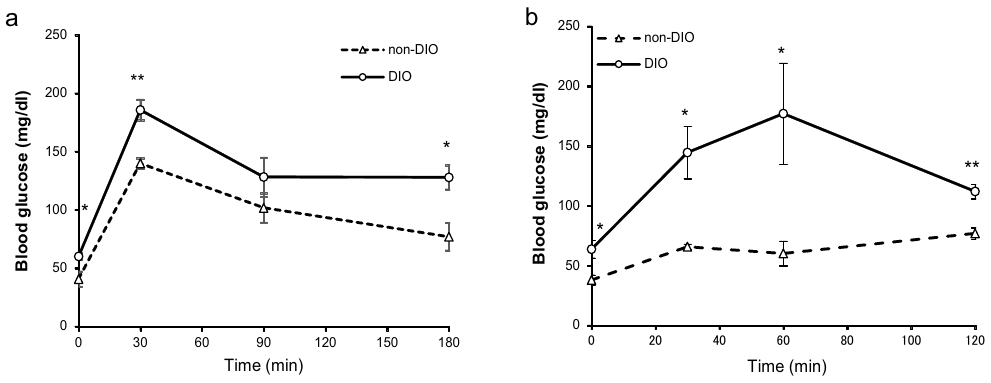
Figure 2. Impaired glucose tolerance in DIO zebrafish. ( a ) Intraperitoneal glucose tolerance test (IPGTT) in non-DIO and DIO zebrafish with blood glucose levels determined after fasting (0 min) and 30, 90, and 180 min after intraperitoneal injection of 0.5 mg glucose/g body weight; n = 5 fish/time point. ( b ) Oral glucose tolerance test (OGTT) in non-DIO and DIO zebrafish with blood glucose levels determined after fasting (0 min) and 30, 60, and 120 min after oral administration of 1.25 mg glucose/g body weight; n = 5 fish/time point. Values are means ± SE. * P < 0.05, ** P < 0.01 vs. the non-DIO